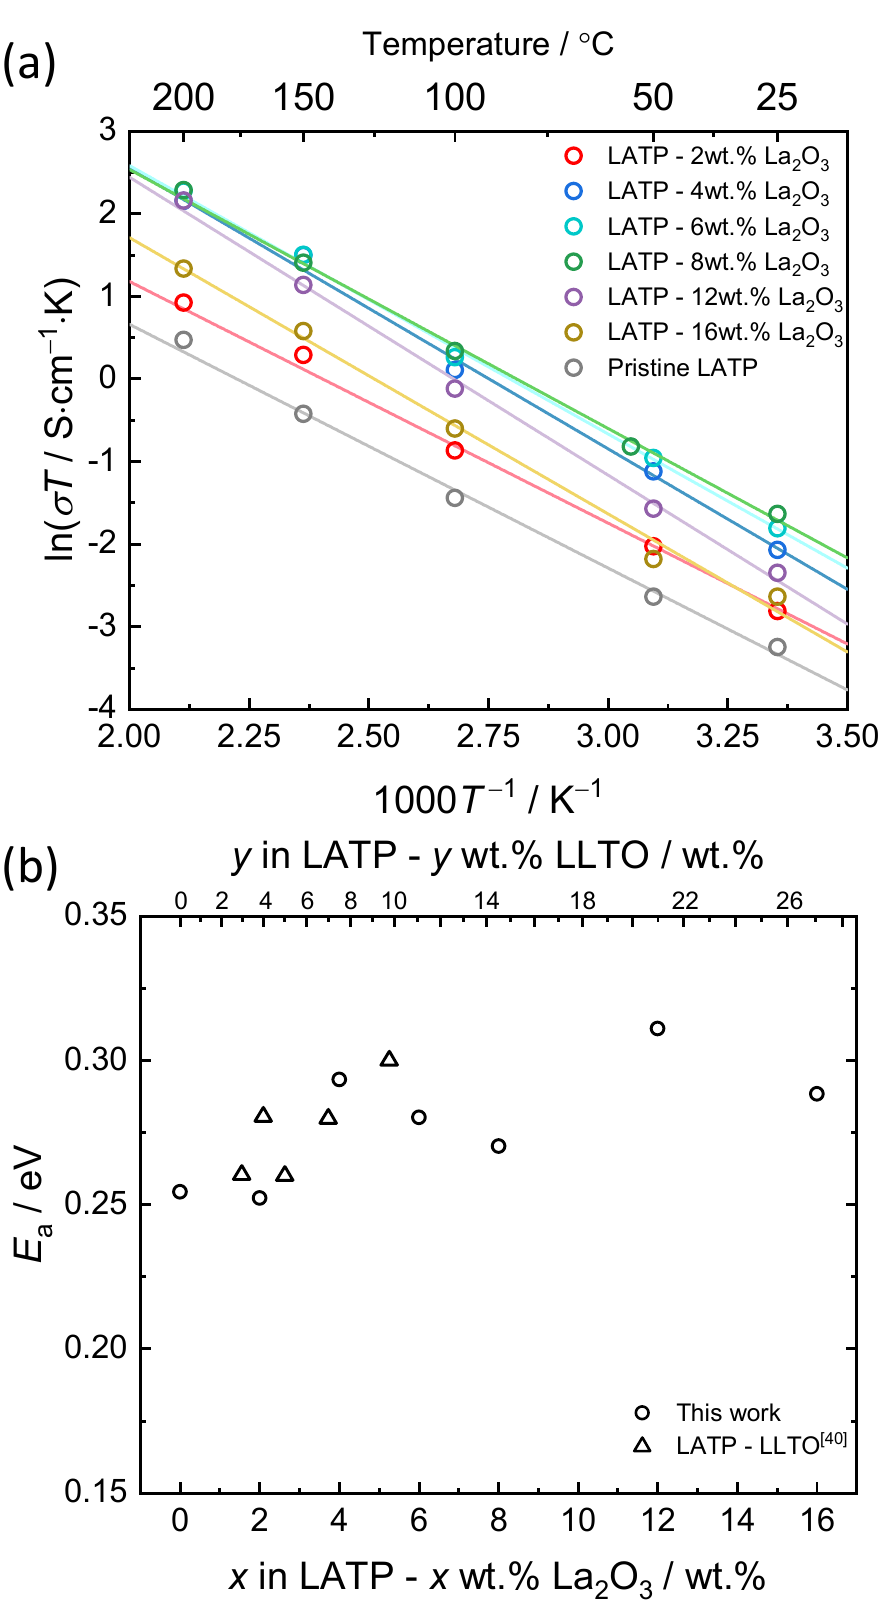
Figure 5. ( a ) Arrhenius plots of LATP–x wt.% La 2 O 3 , and ( b ) activation energies of LATP–x wt.% La 2 O 3 compared with the results of the previous work [40].